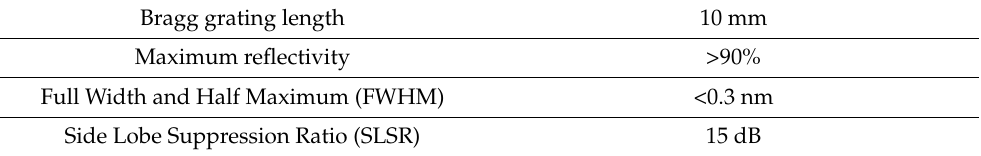
Table 2. FBG characteristics.